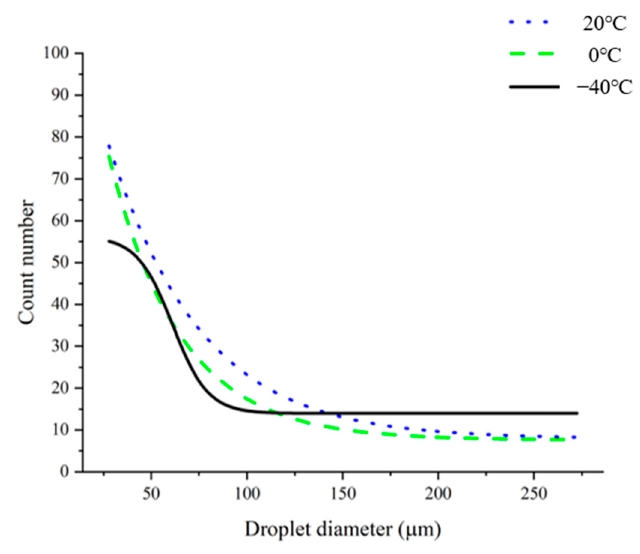
Figure 9. Comparison of the droplet size distributions under different temperature conditions.